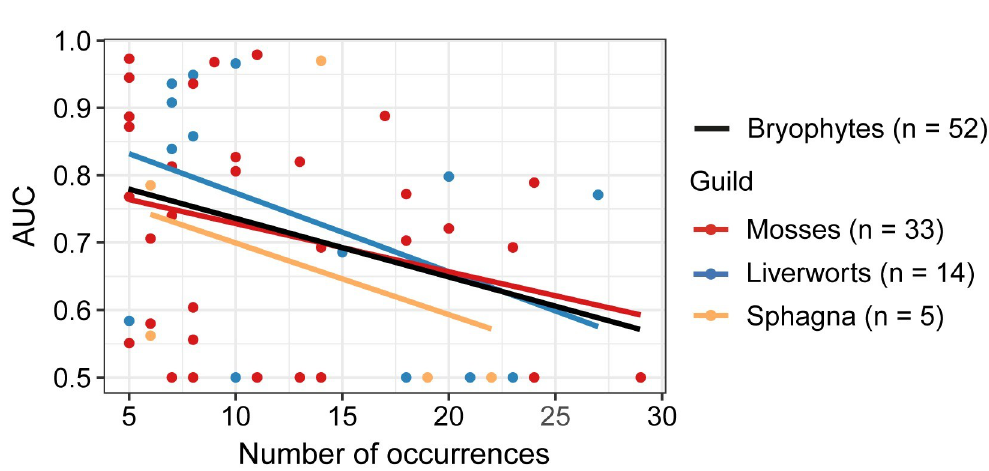
Fig 3. AUC values versus number of occurrences (Overall Pearson r = -0.34). Bryophyte guilds are